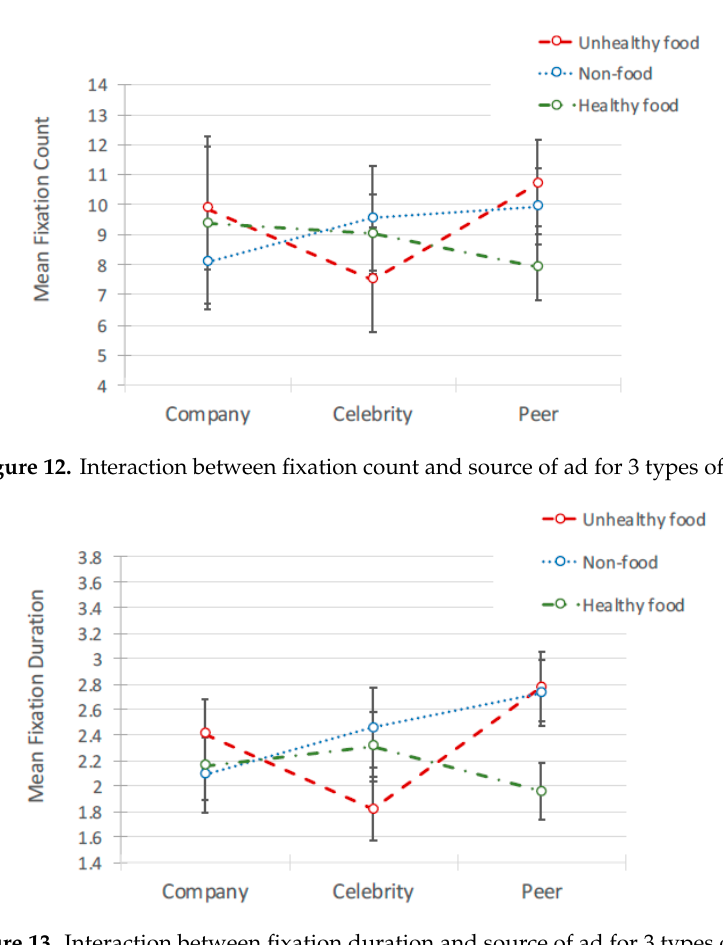
Figure 11. Fixation duration: Mean scores.